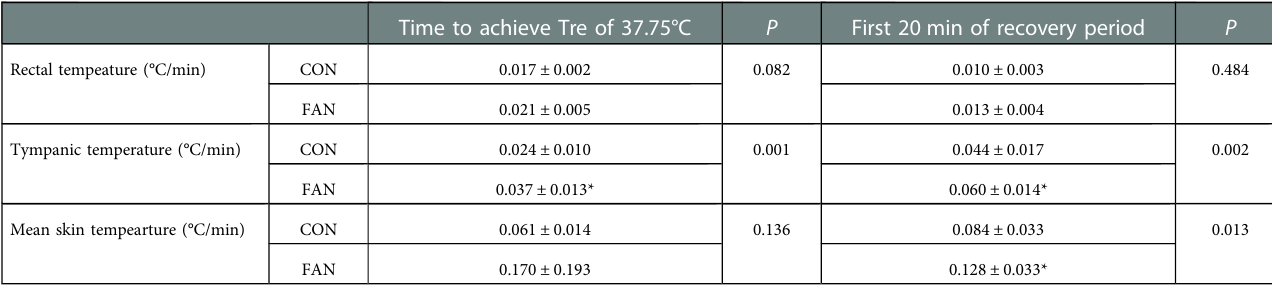
TABLE 2 Cooling rate in each body temperature variable during recovery period. Time to achieve Tre of 37.75°C